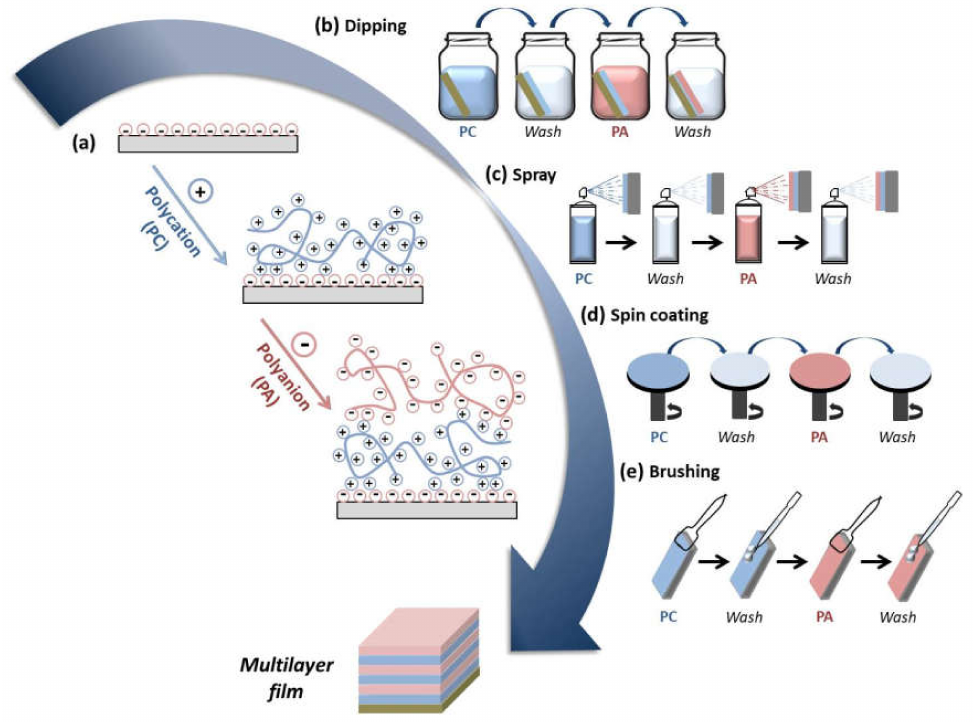
Figure 1. ( a ) Sequential deposition of polycations (PCs) and polyanions (PAs) during the LbL assembly leading to the buildup of a multilayer film; different layer-by-layer (LbL) deposition techniques can be employed for the buildup of multilayer films: ( b ) dipping; ( c ) spray; ( d ) spin coating; ( e )